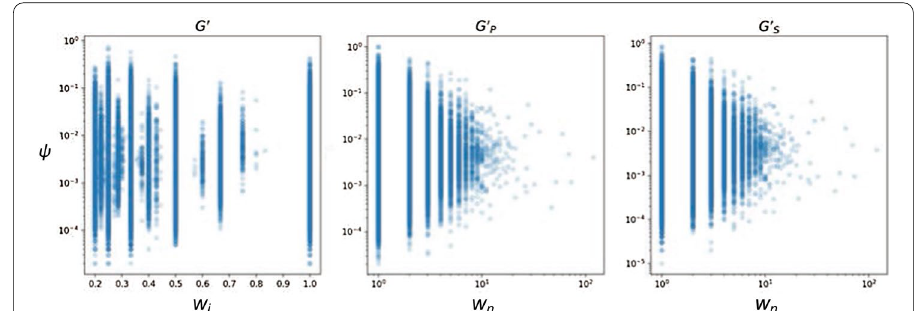
Fig. 6 Comparison of the best w n and w j against the topic similarity